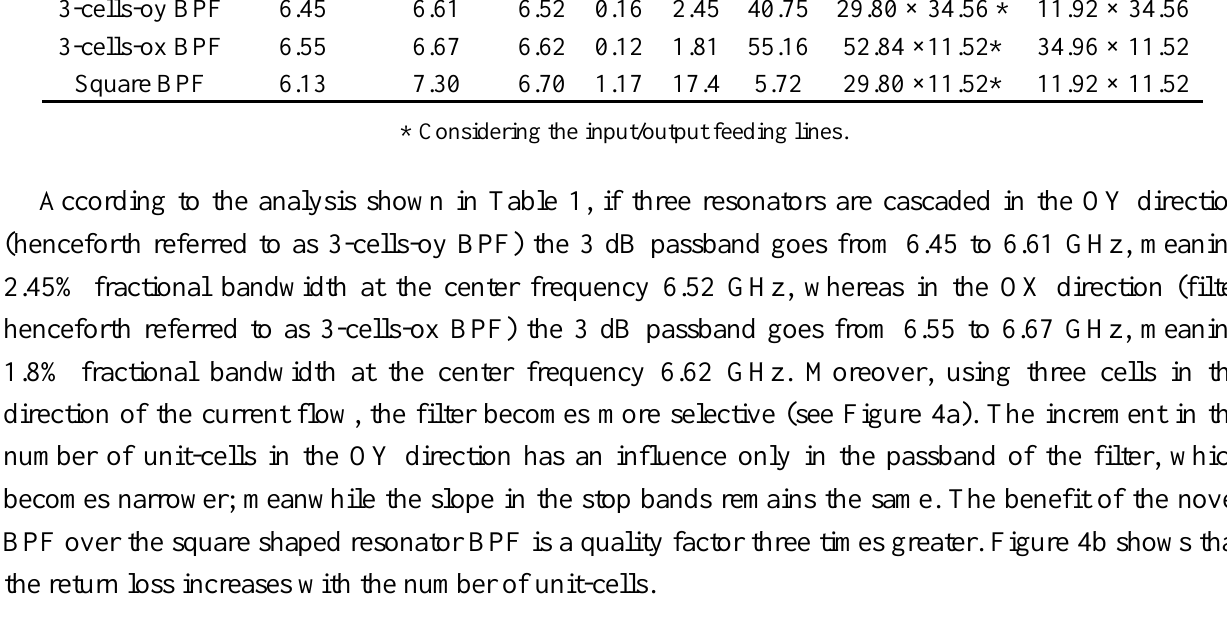
Figure 4. ( a ) S21 simulation results; and ( b ) S11 simulation